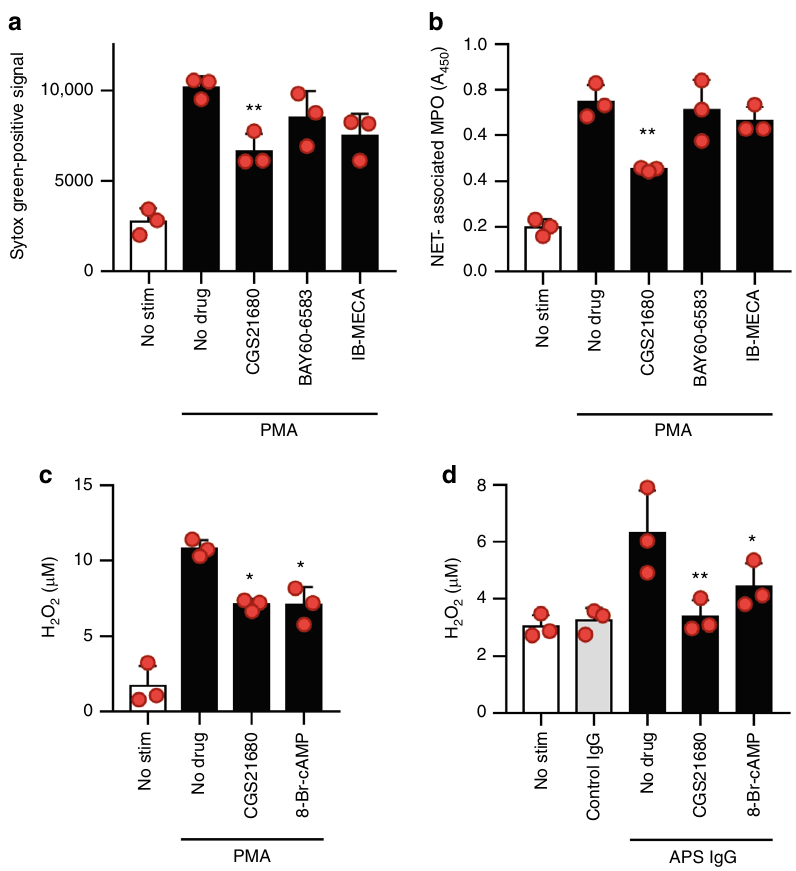
Fig. 3 An adenosine A 2A receptor agonist suppresses reactive oxygen species (ROS). a , b Neutrophils were isolated from healthy volunteers and then treated with PMA for 3 h. Some samples were additionally treated with agonists of the adenosine A 2A receptor (CGS21680), A 2B receptor (BAY60-6583), or A 3 receptor (IB-MECA). In panel a , total extracellular DNA was measured as relative fl uorescence units upon the addition of Sytox Green. In panel b , an independent set of experiments was performed, with NETosis quanti fi ed by measuring the enzymatic activity of nuclease-liberated myeloperoxidase (MPO). Mean and standard deviation are presented for n = 3 independent experiments; ** p < 0.01 as compared with the PMA/no-drug group by one-way ANOVA corrected with Dunnett ’ s test. c , d Neutrophils were treated with PMA, control IgG, or APS IgG in the presence or absence of the A 2A receptor agonist or 8-Br-cAMP for 1 h. Hydrogen peroxide formation was measured by a colorimetric assay. Mean and standard deviation are presented for n = 3 independent experiments; * p < 0.05 and ** p < 0.01 as compared with the PMA-alone group ( c ) or APS-IgG-alone group ( d ) bye one-way